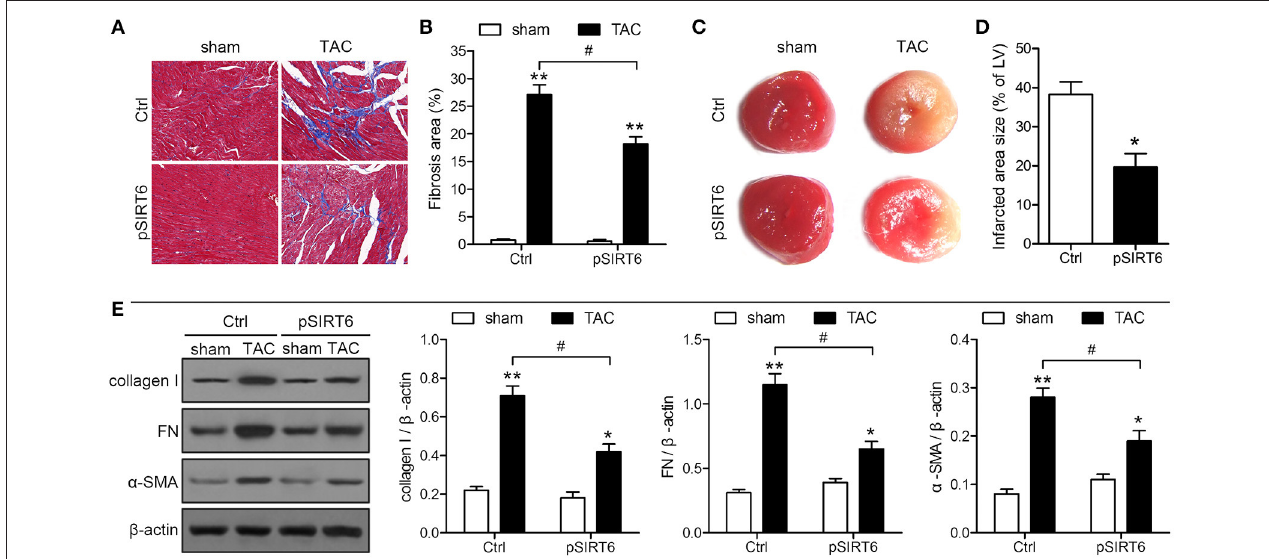
FIGURE 5 | SIRT6 overexpression reduces infarct size and cardiac fibrosis after TAC. Myocardial tissues were collected at 28 days after surgery in control and pSIRT6-injected mice. (A) Representative images of left ventricular sections stained with Masson’s trichrome at 200 × magnification. Fibrotic areas are stained in blue. (B) Quantification of fibrotic areas. ** P < 0.01 vs. sham group, # P < 0.05, n = 8 per group. (C) Representative images of middle heart sections stained with TTC. The infarct area stained pale white. (D) Quantitative analysis of infarct size in TAC mice from TTC stained images. * P < 0.05 vs. Ctrl group, n = 6 per group. (E) Protein expression levels of collagen I, fibronectin (FN) and α -SMA were analyzed by western blotting and normalized to β -actin expression levels. * P < 0.05, ** P < 0.01 vs. sham group. # P < 0.05, n = 10 per